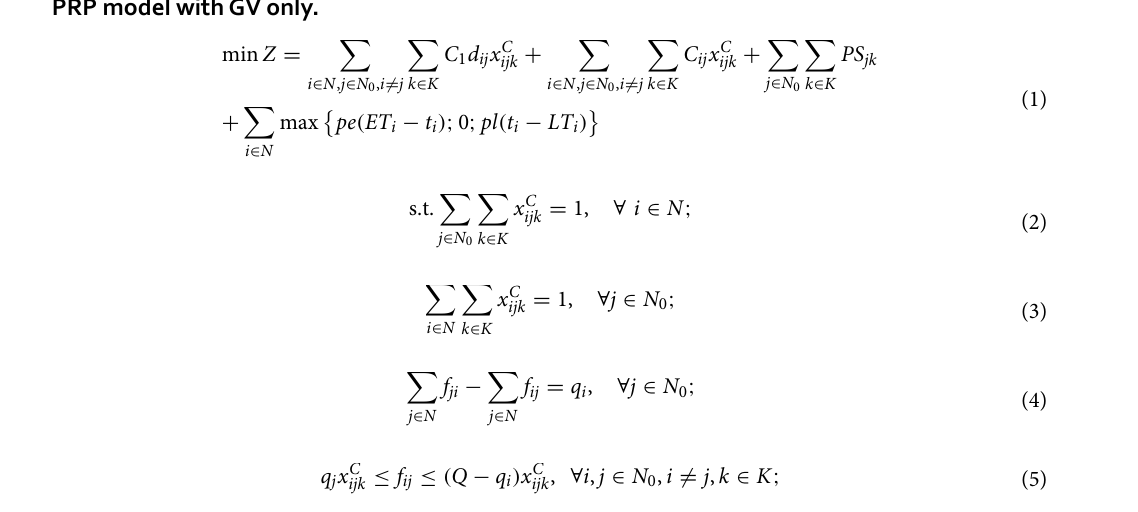
Table 1 details the variables and parameters involved in the TWMOPRP model proposed in this